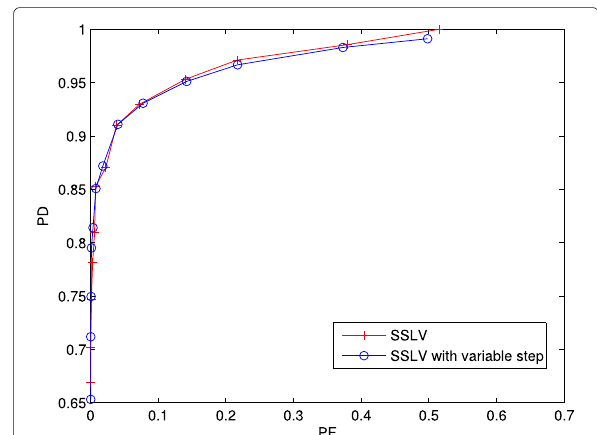
Fig.6 ProbabilityofdetectionforMAversus σ 2 .Here,wehave N (cid:2) =27, b = 5, M x = 3, σ w 2 = 6, and f ov = 5. Simulations are based on 5000 runs